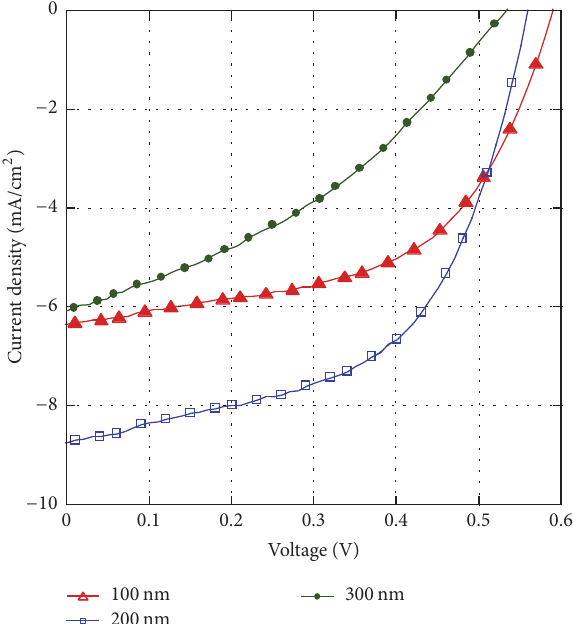
Figure 2: J-V characteristics under illumination for different thicknesses of the active layers. The structure of the devices is ITO/PEDOT:PSS/P3HT:PC 70 BM/Al.